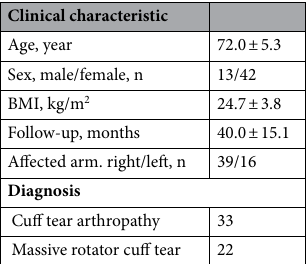
Table 1. Demographic data. BMI body mass